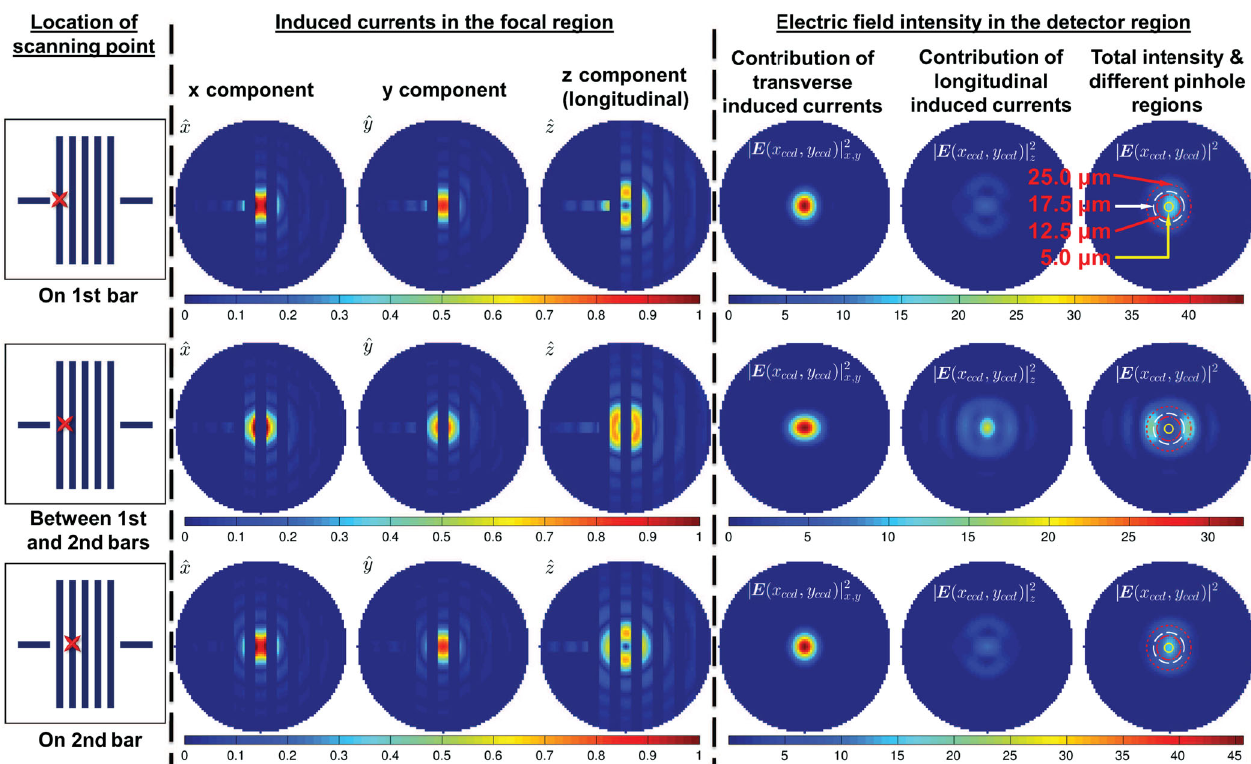
FIG. 7. Effect of longitudinal currents and pinhole size. Analysis of image formation and contribution of longitudinal currents for three scanning points. Three scanning points, shown in the left-hand panel, are considered. Induced current distributions in the focal plane (center panel) and electrical intensities at the detector (right-hand panel) corresponding to each scanning point are shown adjacent to it. The x - y plane is the lateral or transverse plane and the z axis is the longitudinal direction. In the rightmost figures, along with the total electric intensity at the detector, the integration regions for various pinholes are also